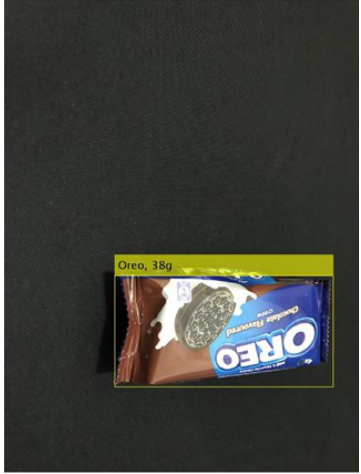
Figure 21. Sample result of correctly validated